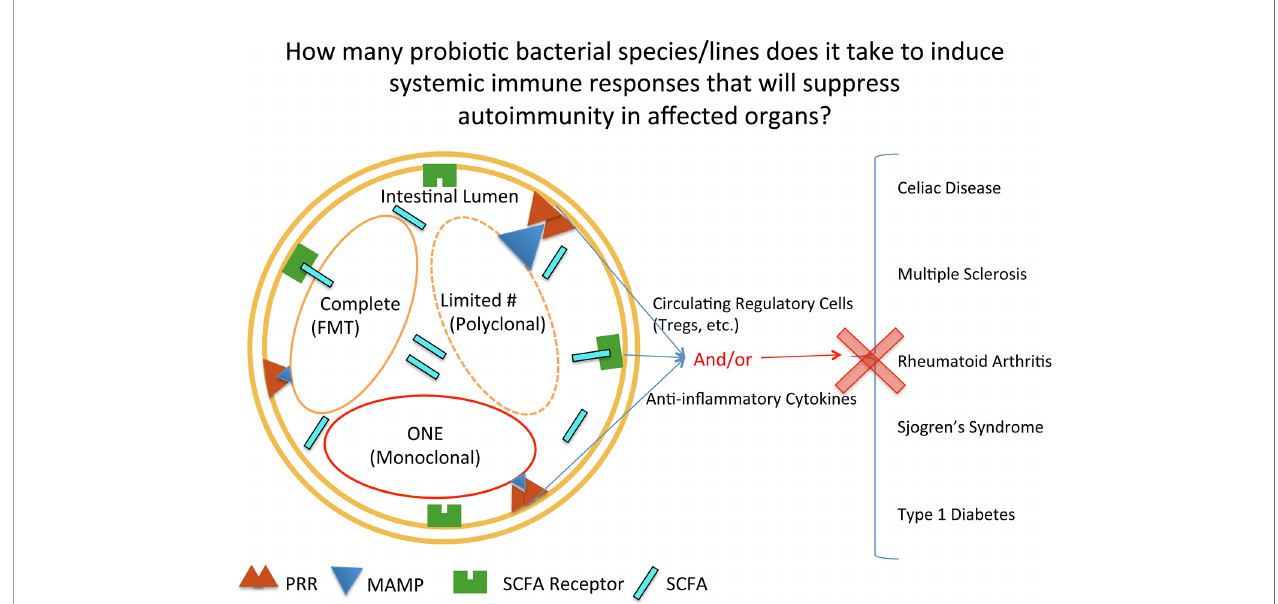
FIGURE 1 | Mechanisms by which probiotic bacterial therapies can affect in fl ammation at intestinal and extraintestinal sites. Depicted in the intestinal lumen are the three main categories of bacterial groups currently used in clinical trials, re fl ecting quantity: complete, restricted mix (Limited#/Polyclonal), and one (monoclonal). PRR, pattern recognition receptor; MAMP, microbe associated molecular pattern; SCFA, short chain fatty acid; SCFAR, SCFA